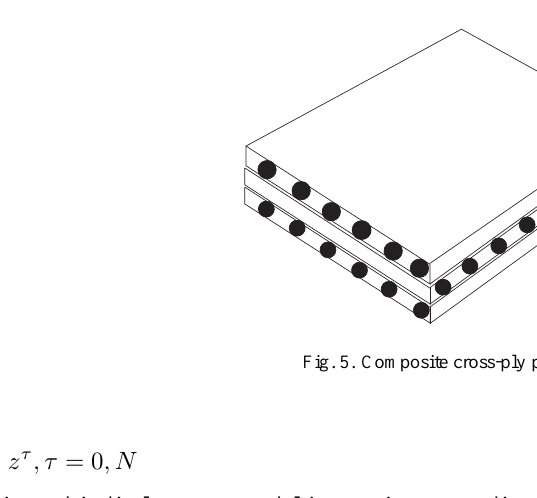
Fig. 4. Multilayered plates made of two different metallic materials.